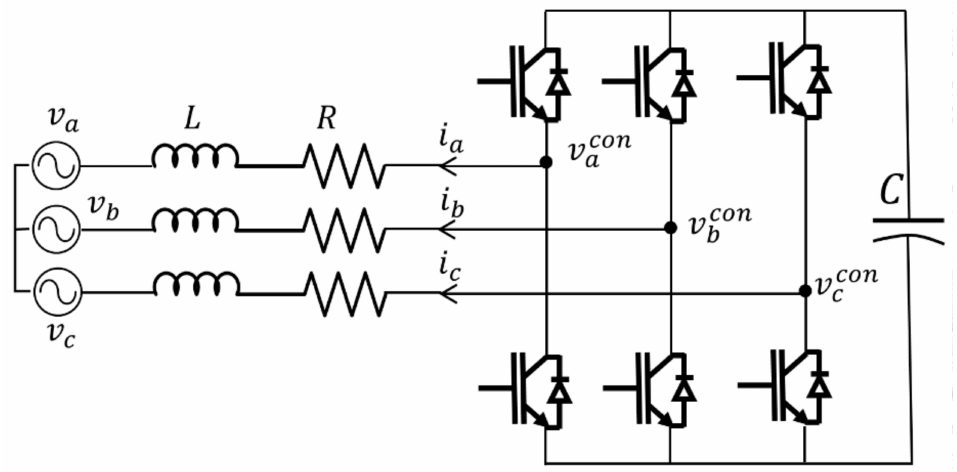
Figure 4. The i th converter equivalent